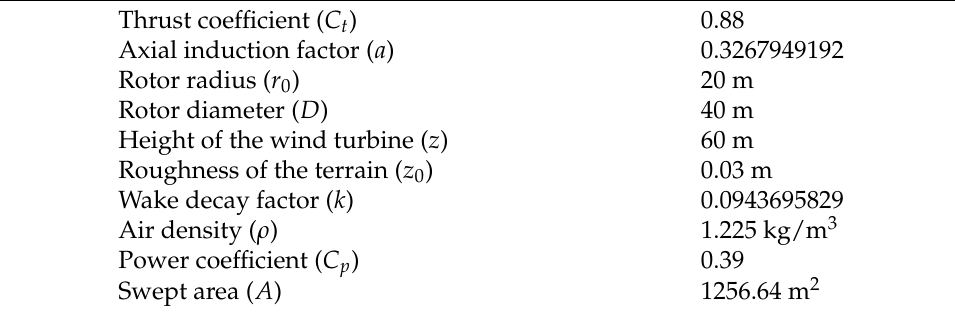
Table 1. Properties of the wind farm proposed by Mosetti et